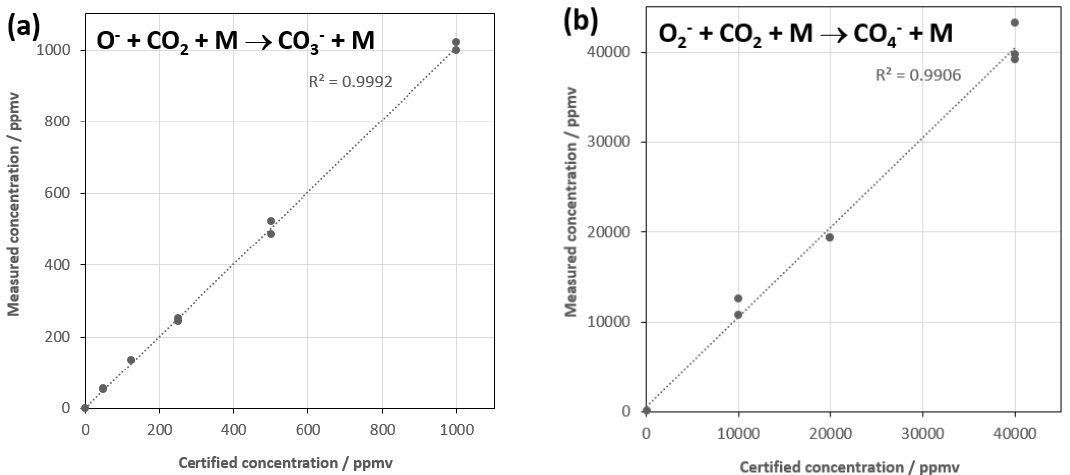
Figure 3. Measured concentrations of CO 2 when using the association reactions O − + CO 2 + M ( a ) and the O 2 − + CO 2 + M reaction ( b ).